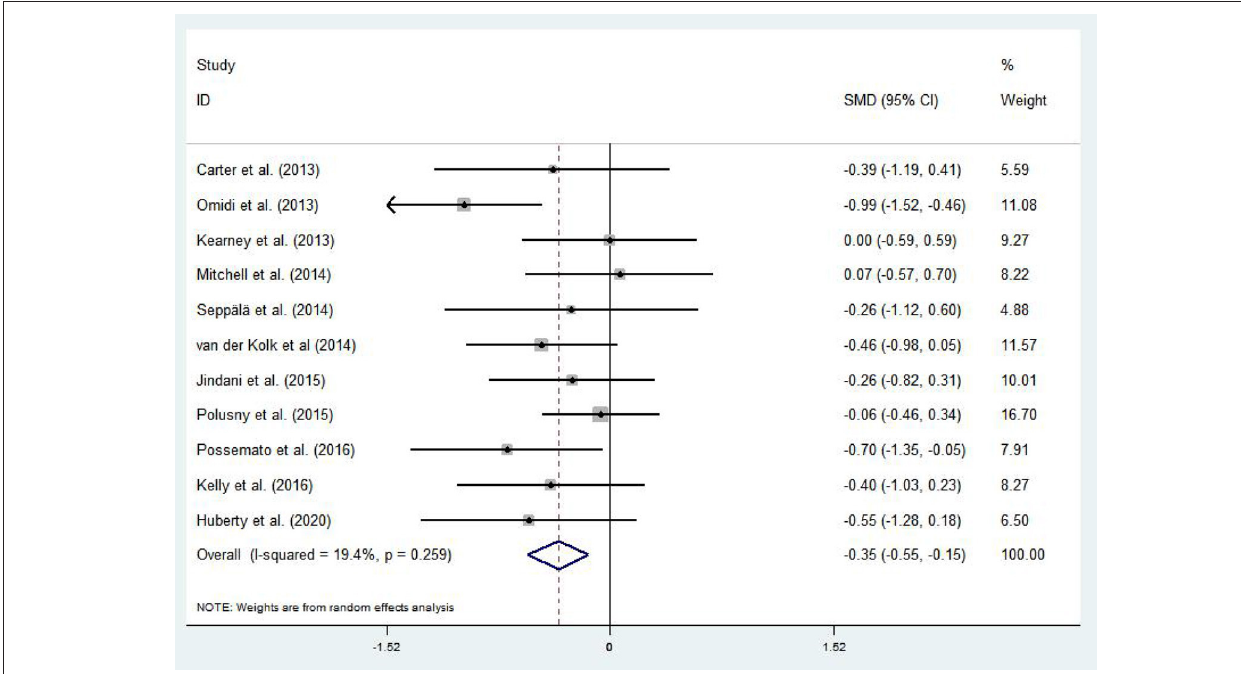
FIGURE 5 | Effect of mind–body exercises on depression.